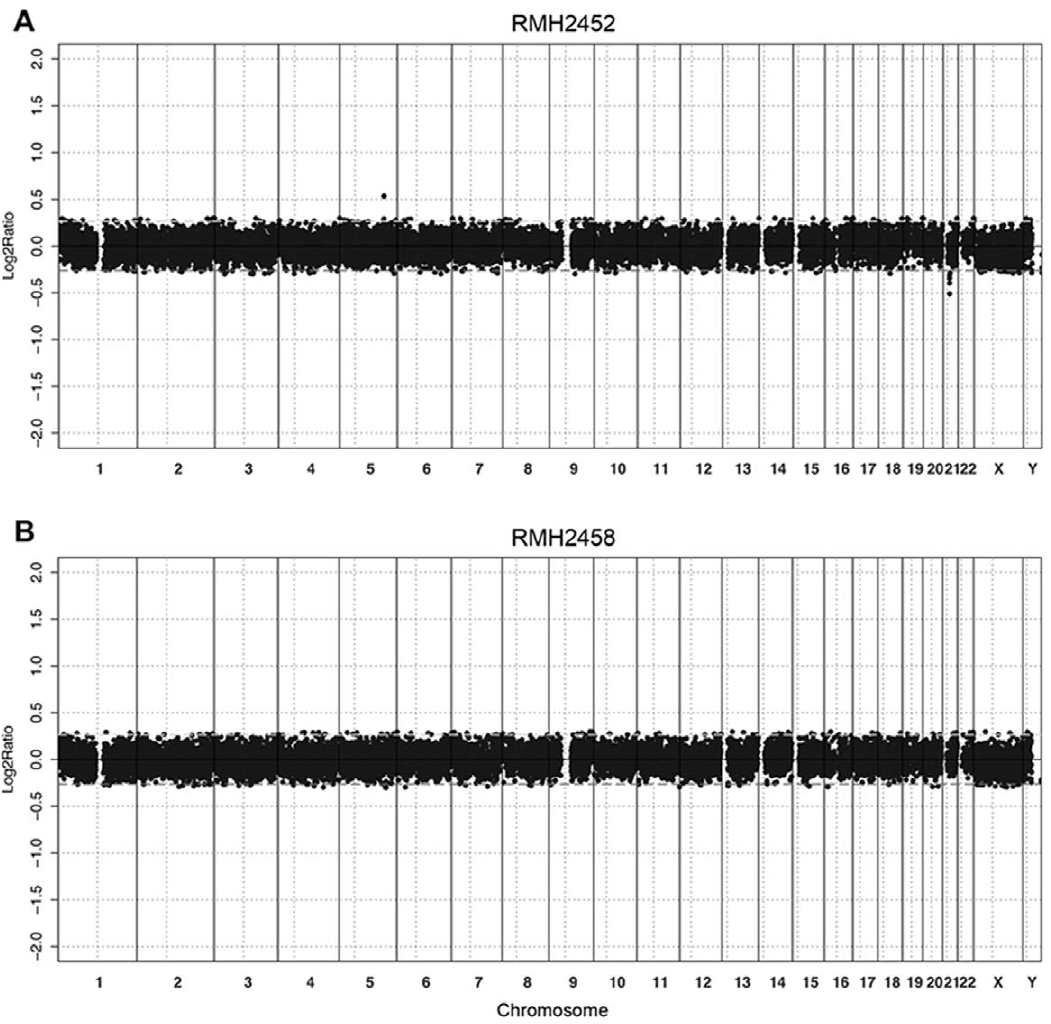
Figure 2. Genomic stability in MSI pediatric HGG. Array CGH genome plots are shown for two MSI-positive pediatric HGG, the MSI-H RMH2452 (A) and the MSI-L RMH2458 (B), demonstrating lack of large scale alterations detectable on the 32K BAC platform. Log 2 ratios for each clone (y axis) are plotted according to chromosomal location (x axis). The centromeres are represented by vertical lines.